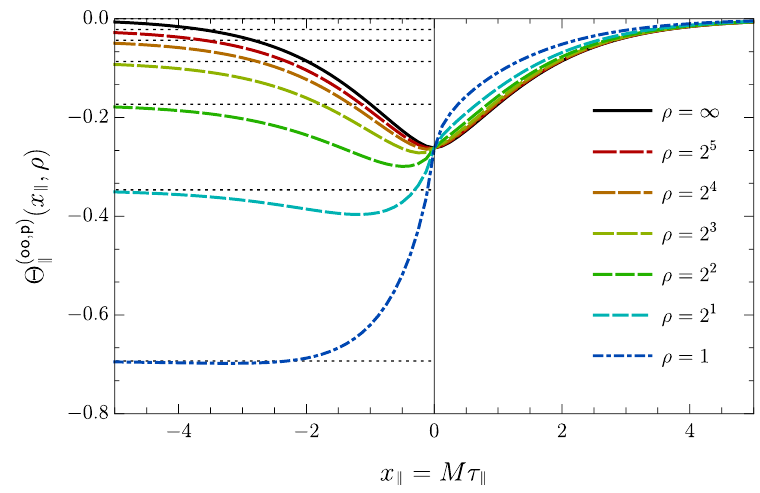
( oo , p ) ( x , ρ ) for different values of the aspect ratio ρ ≥ 1. Figure 3: Scaling function Θ For larger ρ the two open boundaries are getting farther away from each other, thus their interaction becomes irrelevant and the scaling function converges to the limiting ( p ) ( x ) . For ρ = 1 the scaling function converges to ln2 for x → −∞ , case of Θ b which describes the difference between the two limiting procedures of the scaling limit and the thermodynamic